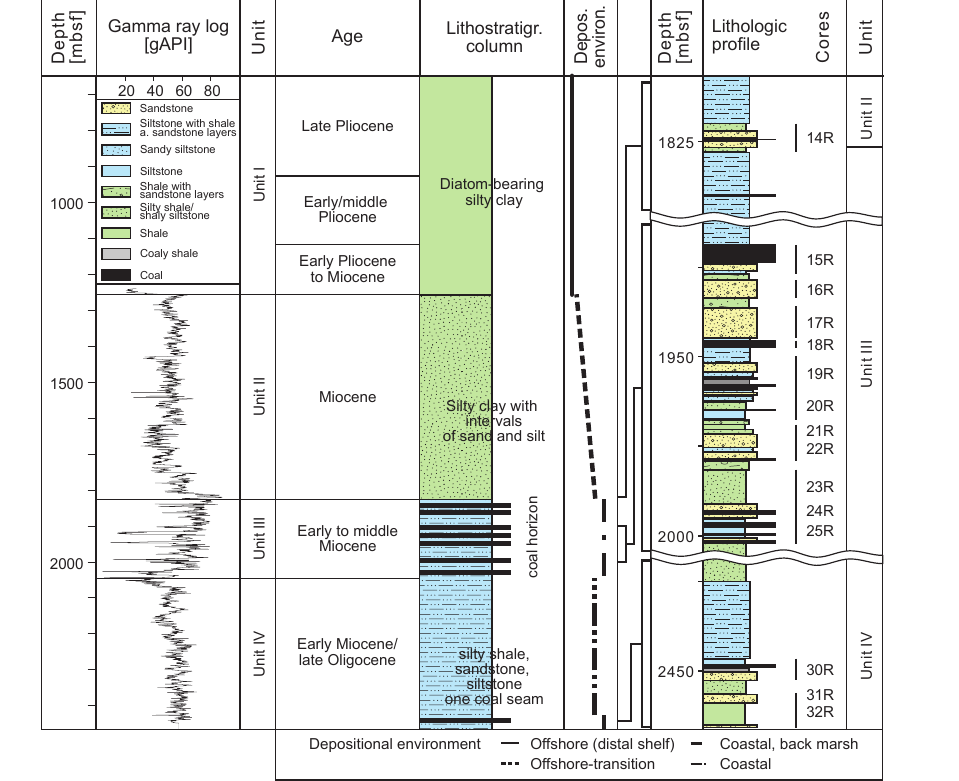
Figure 2. Lithologic profile of Hole C0020A based on macroscopic observation of cuttings (middle and right column) and cores (right column) recovered during Expedition 337. Gamma-ray log and positions of spot-cores are also plotted. This figure is slightly modified from Fig. 2 in Gross et al. (2015), and reprinted with permission from